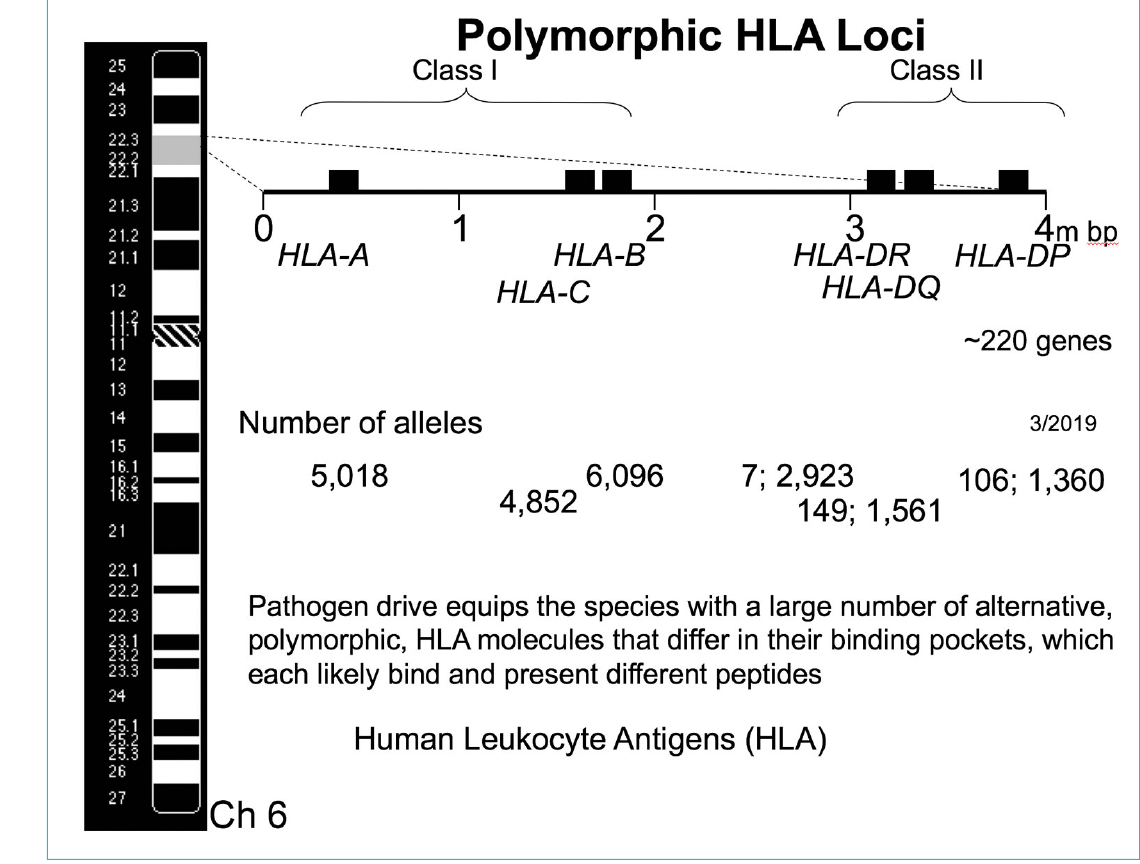
Figure 2: The overall genetic organization of the HLA gene complex, located on the short arm of chromosome 6. This gene complex is ap- proximately 4 million base pairs in length and the principal illustrated HLA loci are divided into two main functionally different classes, class I and class II. These classes reflect the two fundamentally different immunosurveillance challenges faced by the immune system: identification of an infected cell and an extracellular pathogen. There are three class I loci: HLA-A , HLA-B and HLA-C . The molecules encoded by each of these three loci selects their own repertoire of T cells that recognize different peptides in the context of the respective HLA class I molecule. There are three types of class II HLA molecules designated HLA-DR, HLA-DQ, and HLA-DP, however they consist of two chains, alpha (A) and beta (B), and are synthesized by separate loci. Only the expressed polymorphic HLA loci are illustrated in this simplified figure. The large number of alternative gene forms, or alleles, found at each of these loci is